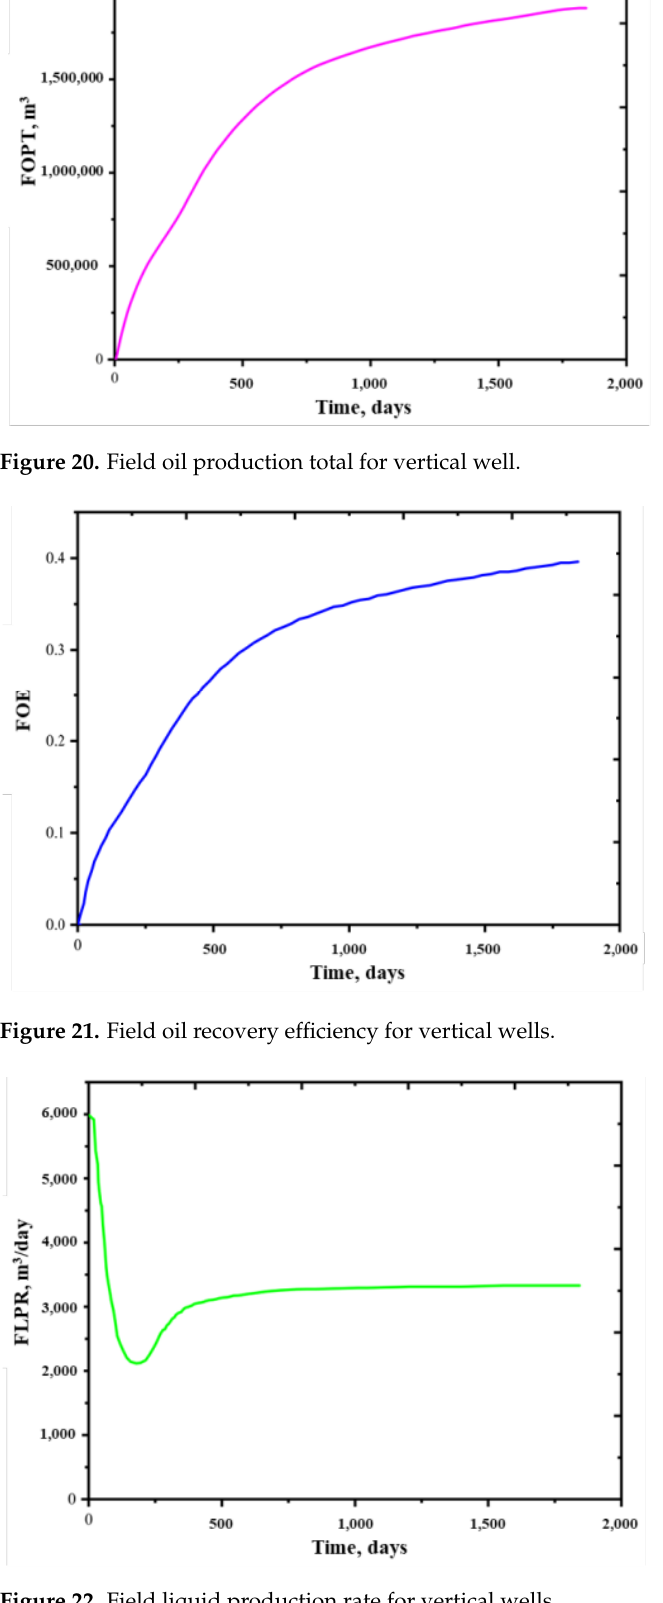
Figure 22. Field liquid production rate for vertical wells.